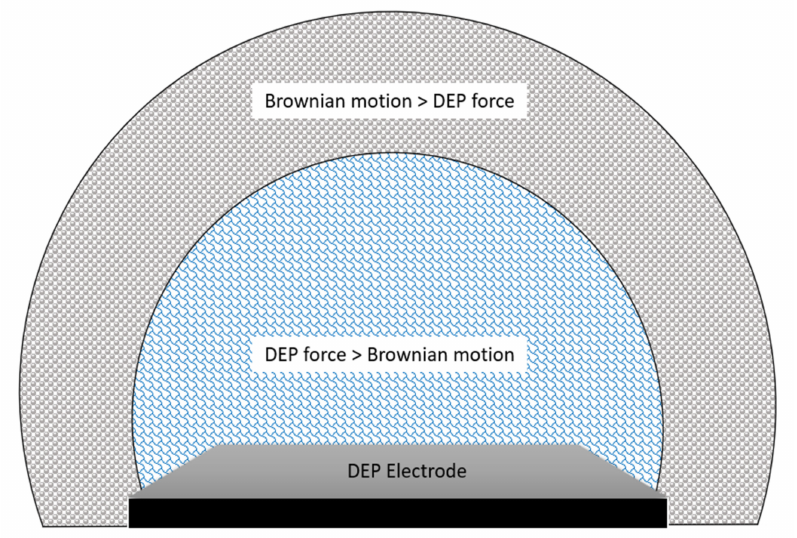
Figure 5. DEP force versus Brownian motion in terms of area of force concentration.